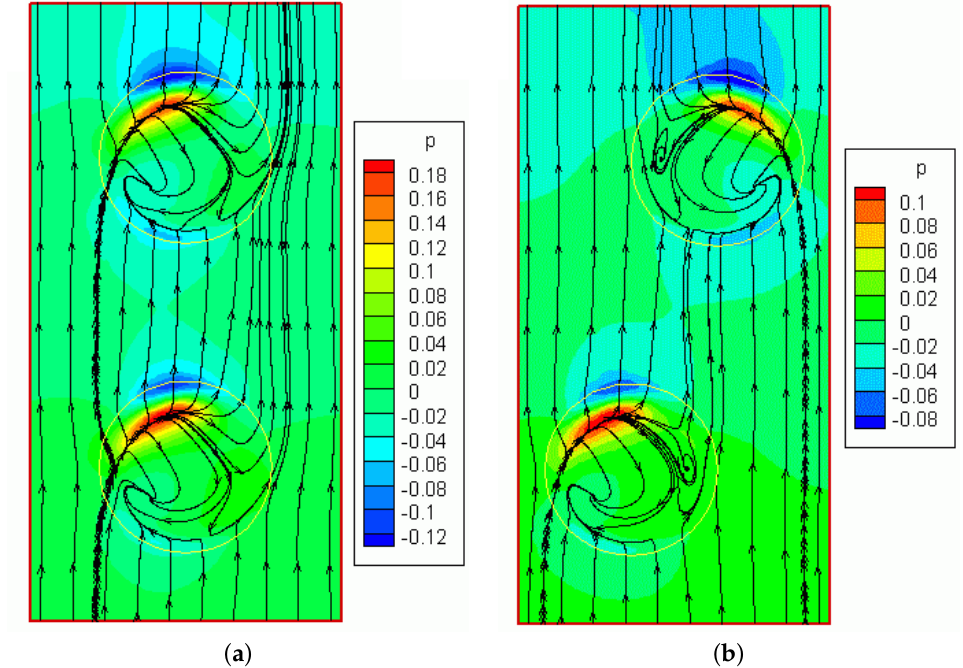
Figure 15. Comparison of patterns of coolant spreading over the wall with spherical dimples 0.2 deep without displacement ( a ) and with displacement 0.25 ( b ) with applied pressure